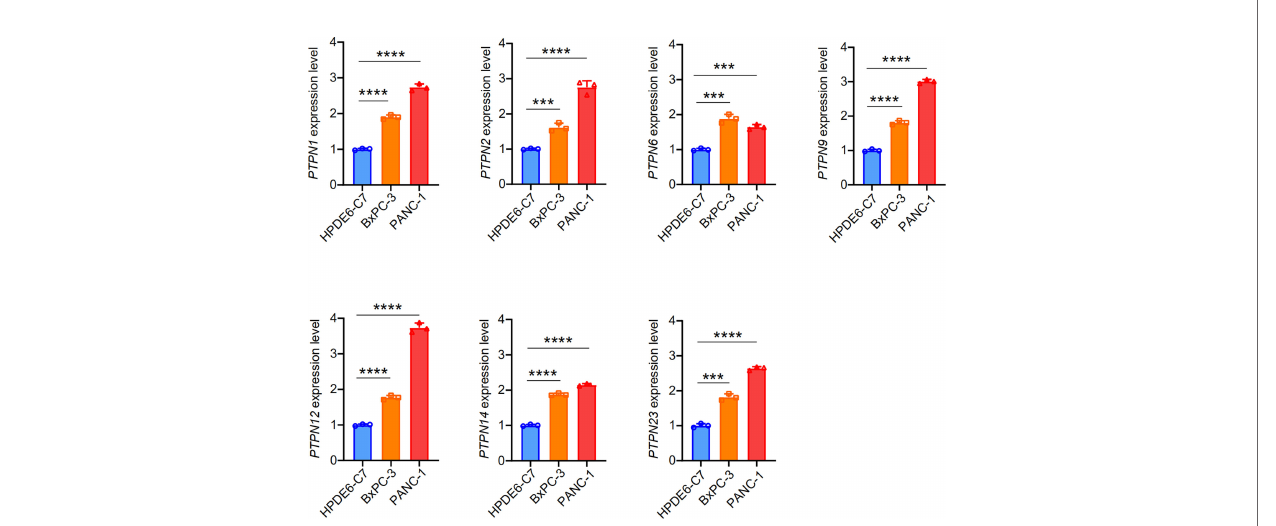
FIGURE 3 | Expression of PTPNs in HPDE6-C7, BXPC-3 and PANC-1 cells. The results from three independent experiments were statistically analyzed using t-test method. ***p < 0.001, ****p < 0.0001.